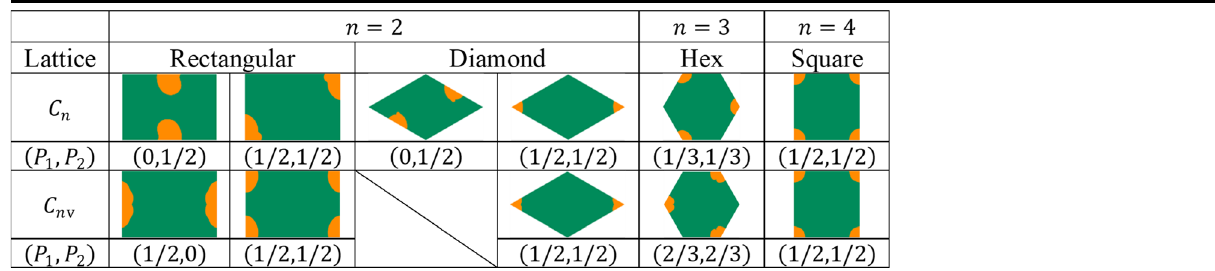
Table A1: Optimized TCIs with TRS among the 2D point groups in Table